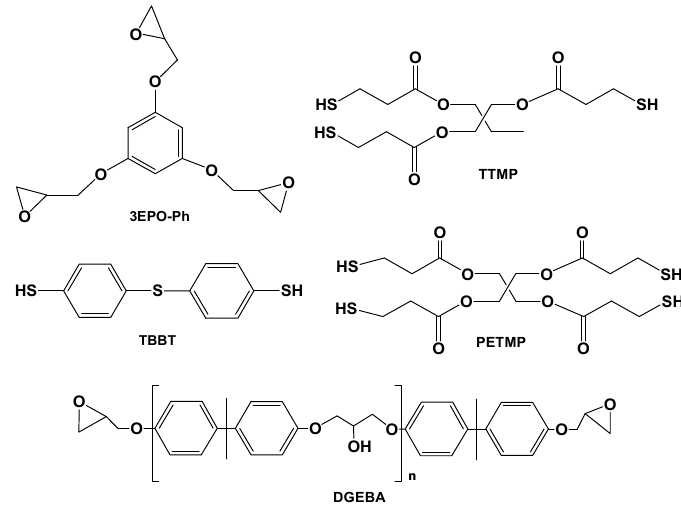
Figure 1. Chemical structures of the monomers